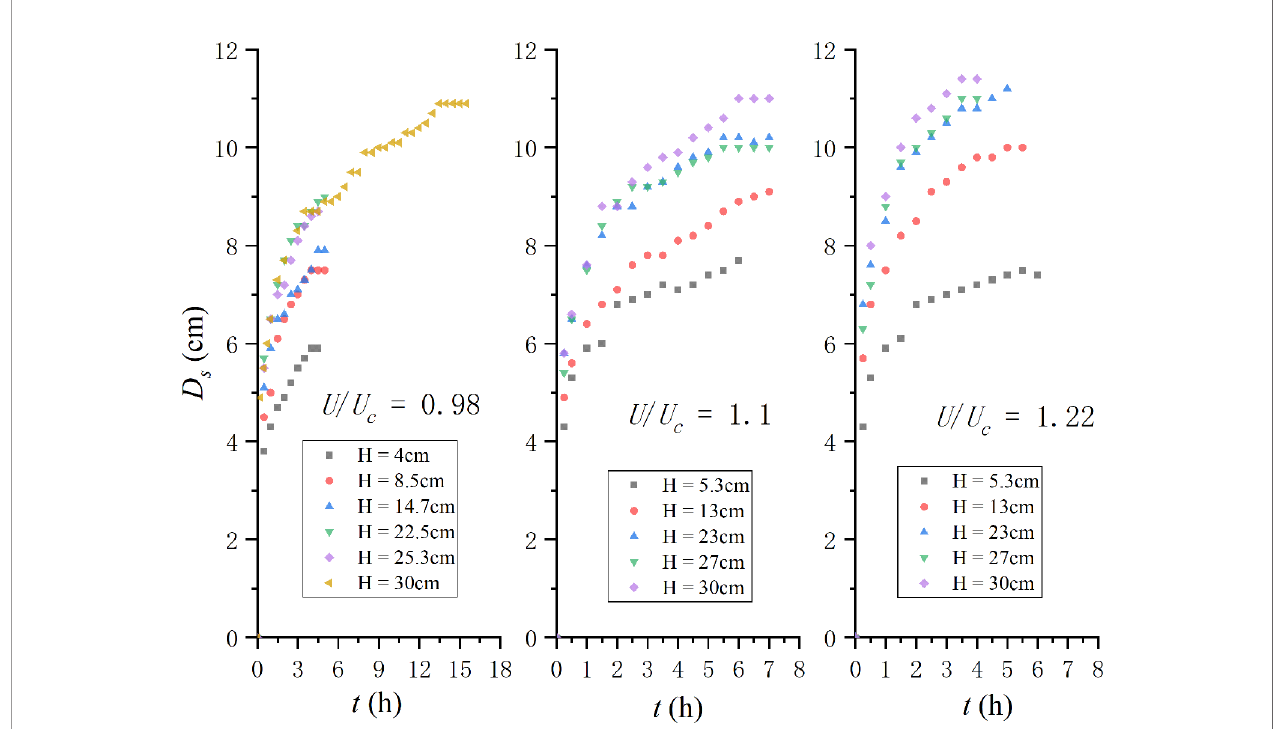
FIGURE 2 | Temporal development of maximum scour depth around pile groups in the present experiments ( H = 30 cm represents the non-submerged pile